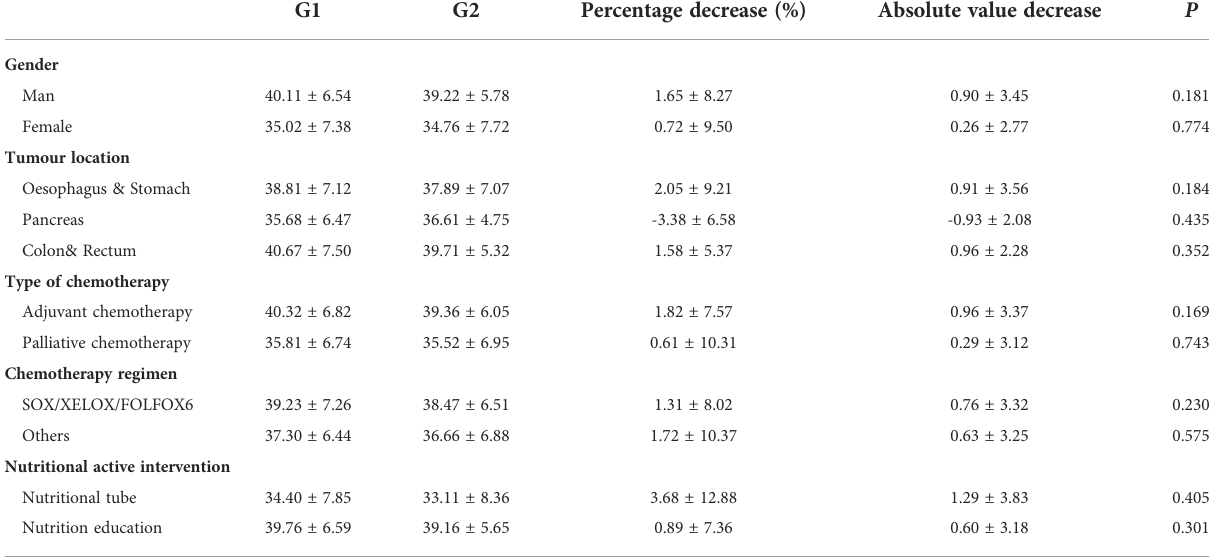
TABLE 3 Change in SMI according to different clinical characteristics (cm 2 /m 2